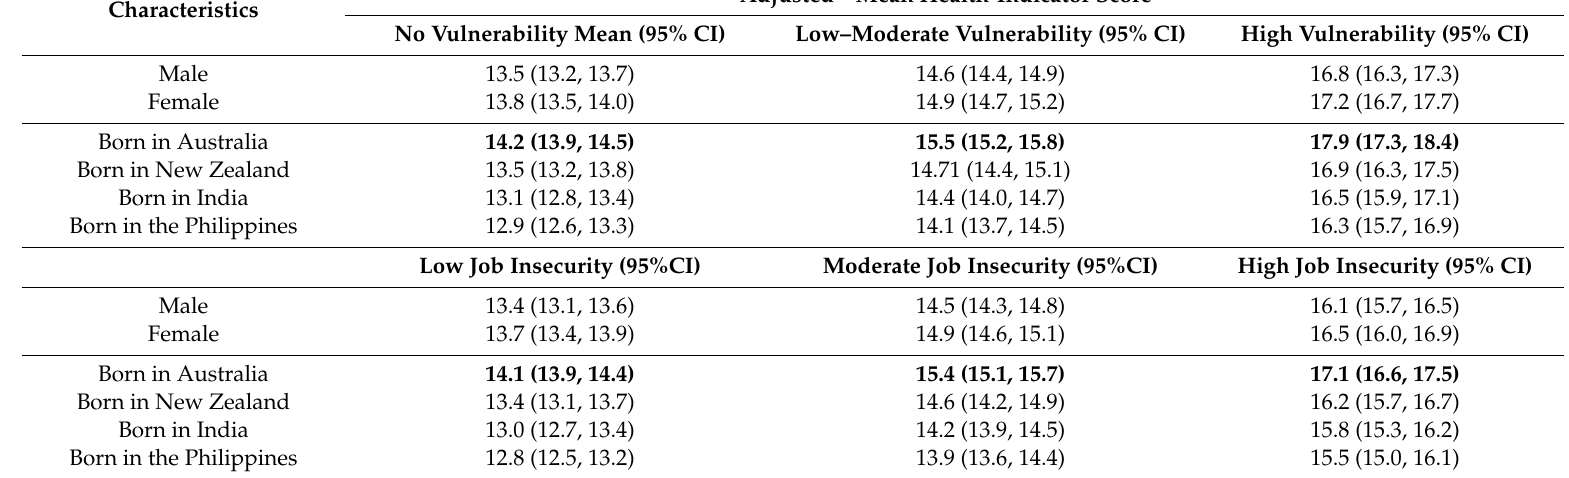
Table 4. Estimated mean health-indicator scores for gender and country of birth by levels of vulnerability and job insecurity, using predictive margins based on the regression